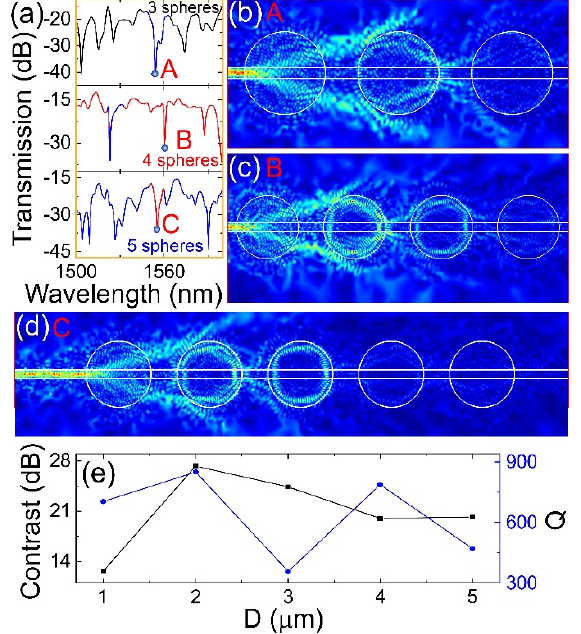
Figure 5. ( a ) The transmission spectra of silica taper-assisted multiple microspheres with D =15 µm and gap = 6 µm under different number of microspheres. ( b – d ) Electric field distributions at points A, B and C in Figure 5a. ( e ) The corresponding comparisons of the contrast and quality factor under different number of microspheres.